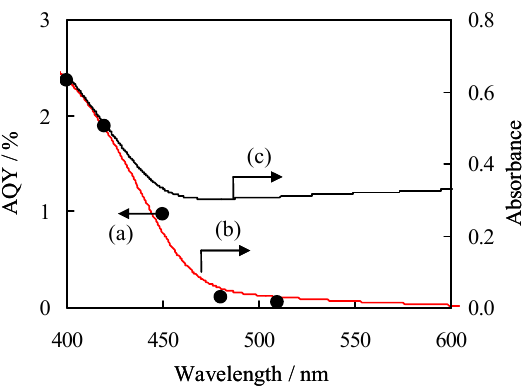
Figure 3. Dependence of wavelength photo-irradiated on apparent quantum yields, AQY (a) for hydroxylation of benzene to phenol, and UV–Vis absorbance of WO 3 (b) and Pt(0.2)-WO 3 (c).